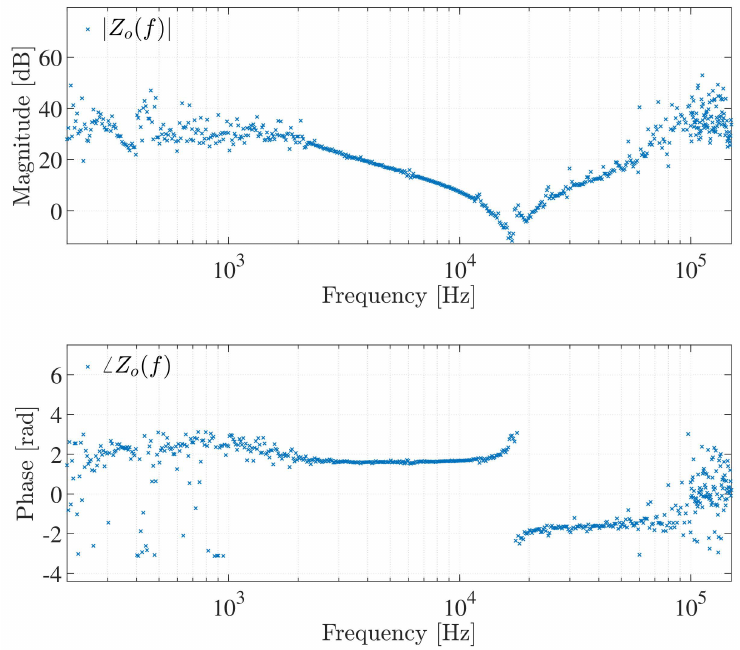
Figure 17. Magnitude and phase response of Z o ( f ) of the practical inverter under investigation using PRIS perturbation.